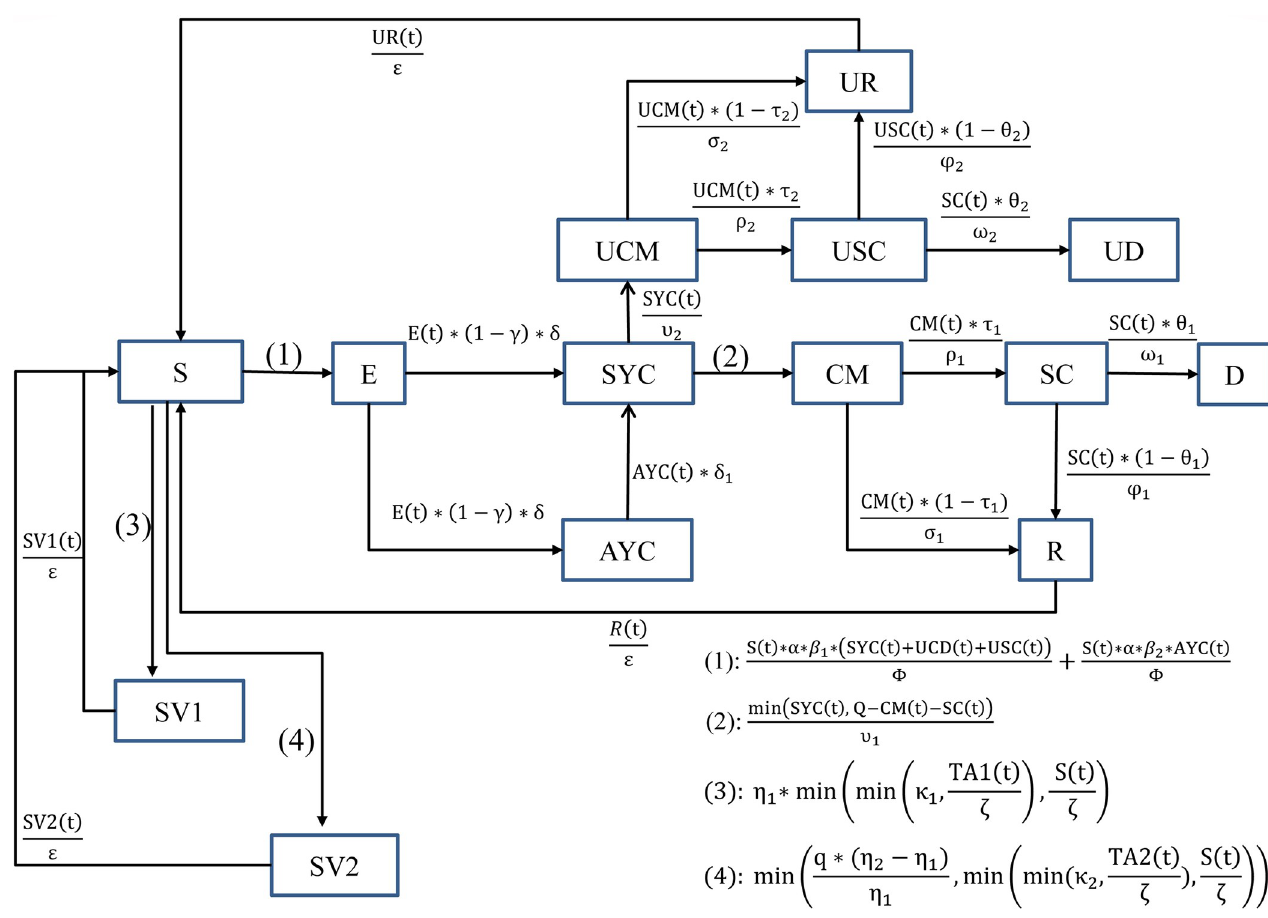
Fig 2. Simplified stock flow diagram for the Ethiopia SEIR